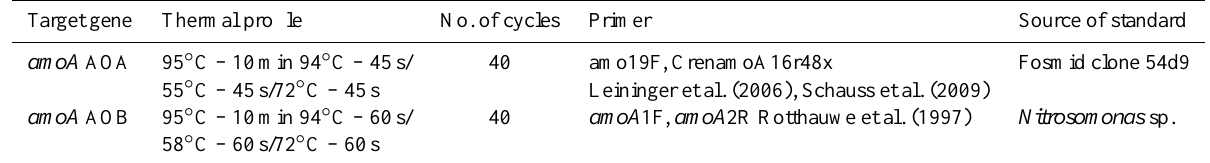
Table 2. Thermal profiles and primers used for real-time PCR quantification of functional genes of ammonia-oxidation. Target gene Thermal